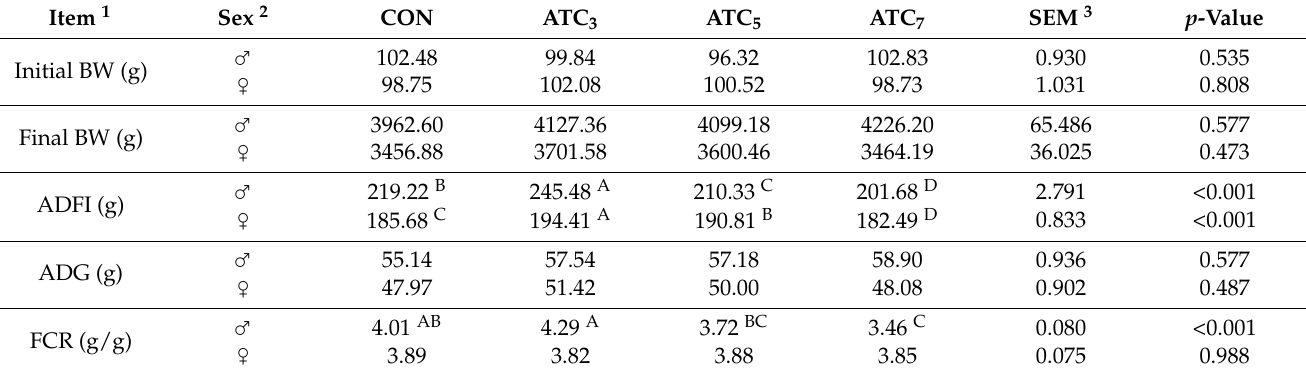
Table 2. The effects of ATC on the growth performance of geese.